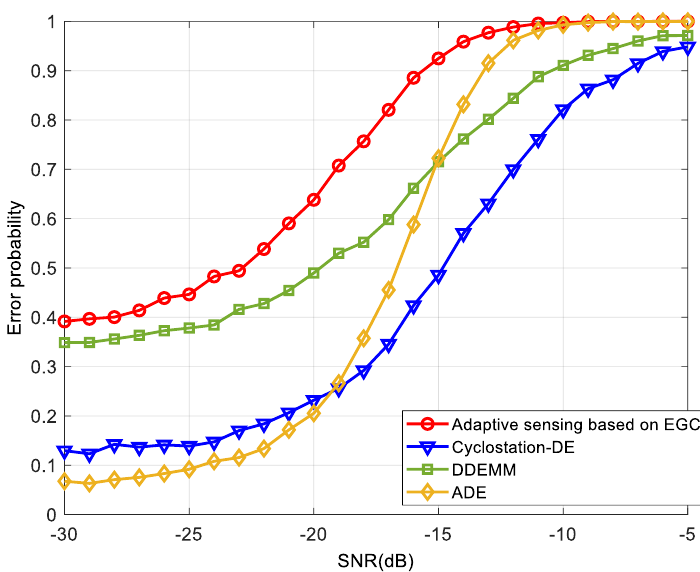
Figure 6. Performance of adaptive double threshold algorithm.